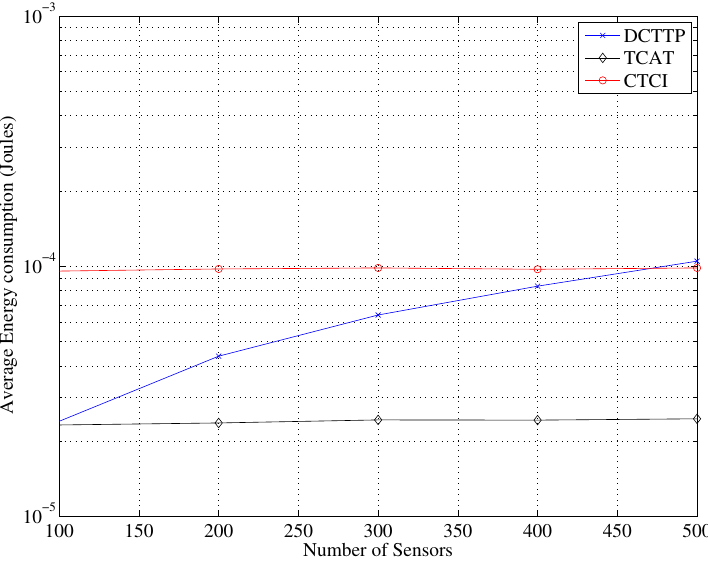
Figure 16. Impact of the number of sensor nodes on the average energy